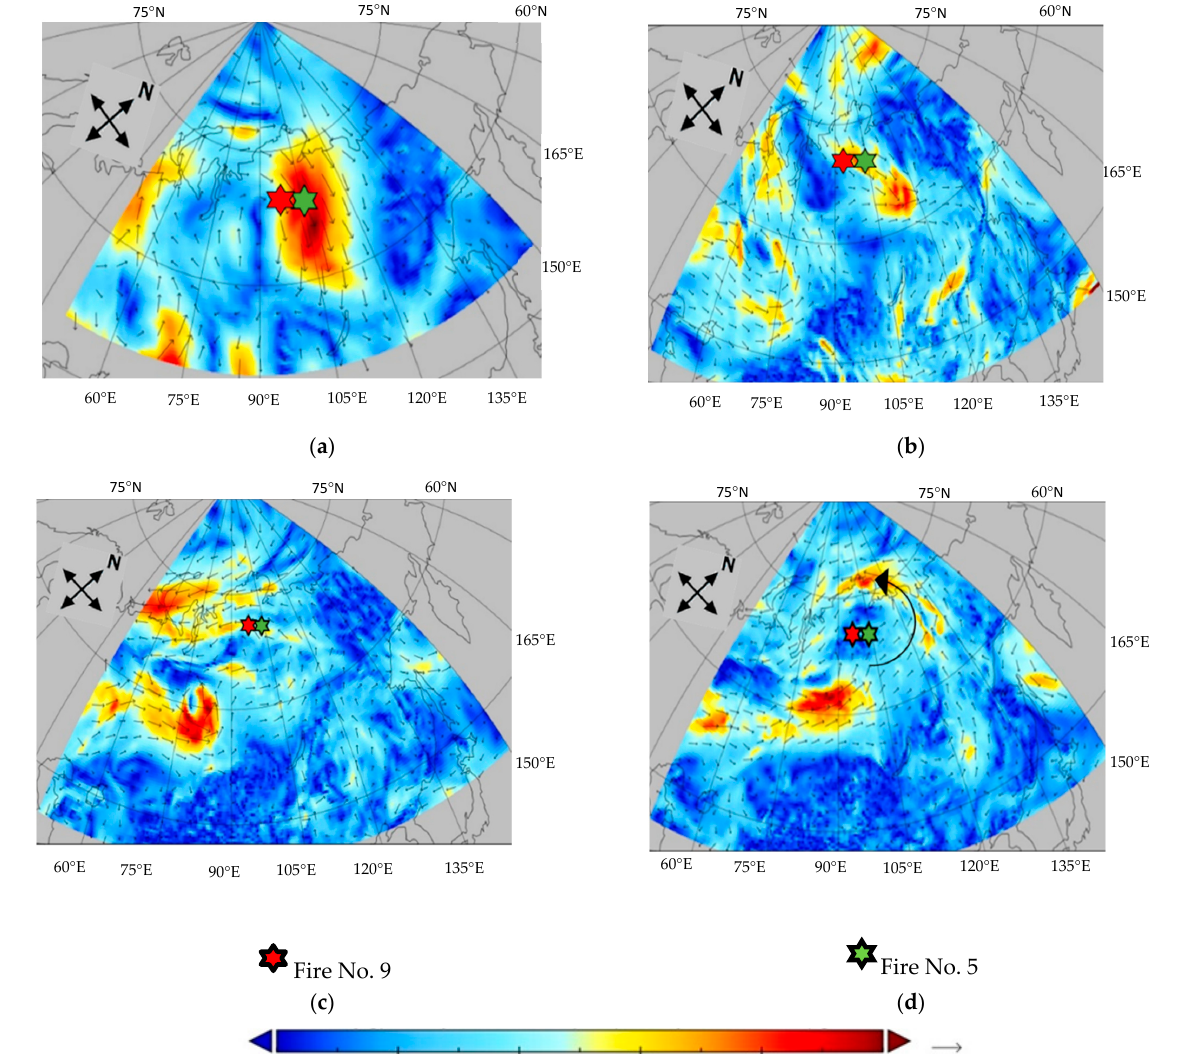
fire No. 5 (Figure 4): three transport directions prevail: southern, eastern and northern, but in this case approximately equal numbers of particles are transported to the south and east, which is apparently associated with weaker speeds of the north wind on the first day Figure 5. Wind speed and direction according to ERA5 reanalysis: 3 July ( a ), 4 July ( b ), 7 July ( c ), 8 July ( d ) 2019 at 12 UTC. at the source of the fire (Figure 5a). Fire No. 9 also occurred on 3 July and lasted for only 2 days, appearing a little further to the west than fire No. 5. In general, the map of the probability distribution of particles transfer from fire No. 9 (Figure 6a) is similar to the distribution map of trajectories during